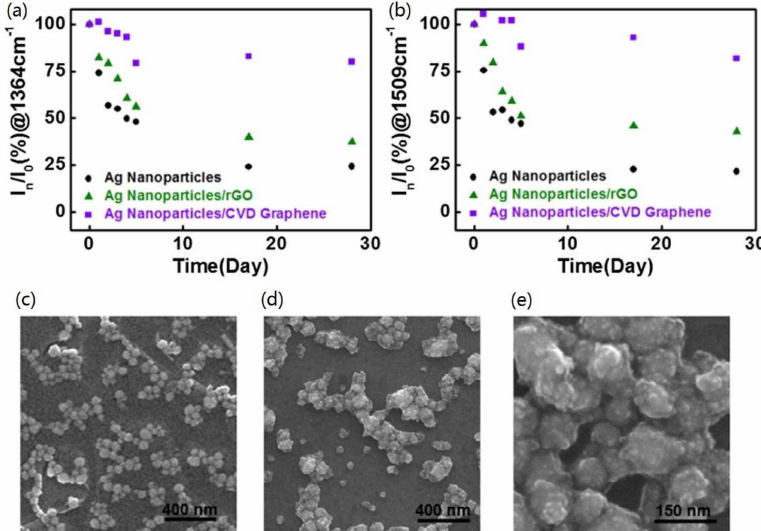
Figure 9. ( a ) The normalized intensity of the R6G Raman peak at 1364 cm − 1 collected using, respectively, the unprotected (black), rGO-protected (green), and CVD graphene-protected (purple) Ag nanoparticles as substrates, versus the time of aerobic exposure; ( b ) the normalized intensity of the R6G Raman peak at 1509 cm − 1 collected using, respectively, the unprotected (black), rGO-protected (green), and CVD graphene-protected (purple) Ag nanoparticles as substrates, versus the time of aerobic exposure; ( c ) SEM image of the CVD graphene-protected Ag nanoparticles after their 28-day use as the SERS substrate for the measurement of R6G; ( d , e ) SEM image of the unprotected Ag nanoparticles after their 28-day use as the SERS substrate for the measurement of R6G. Reproduced from [79] with permission; Copyright Elsevier